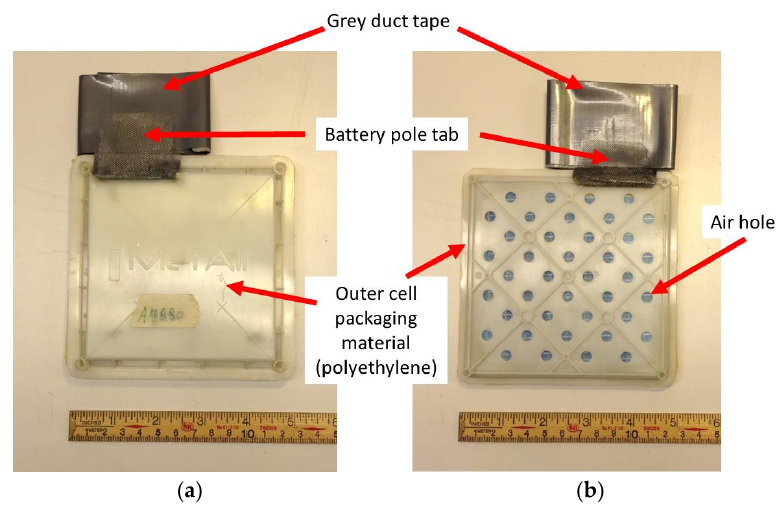
Figure 1. ( a ) Front and ( b ) back photos of the Zn–Air cell.